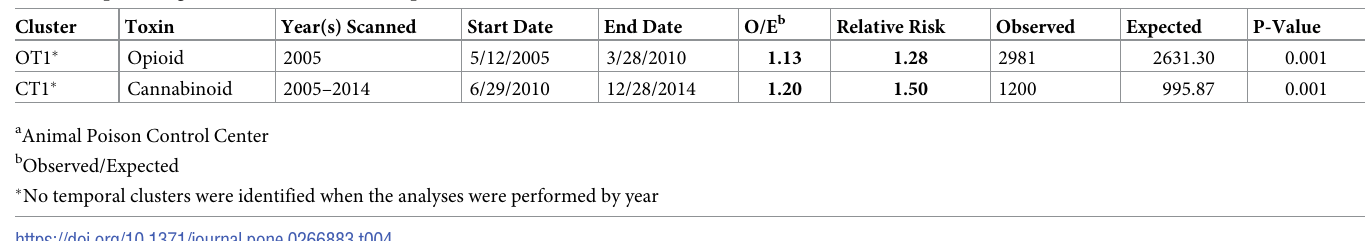
Table 4. Purely temporal clusters identified with the spatial scan statistic using Bernoulli models, where there were statistically significant high proportions of dog- associated poisoning calls to APCC a related to opioids or cannabinoids in the continental US (2005–2014). Cluster Toxin